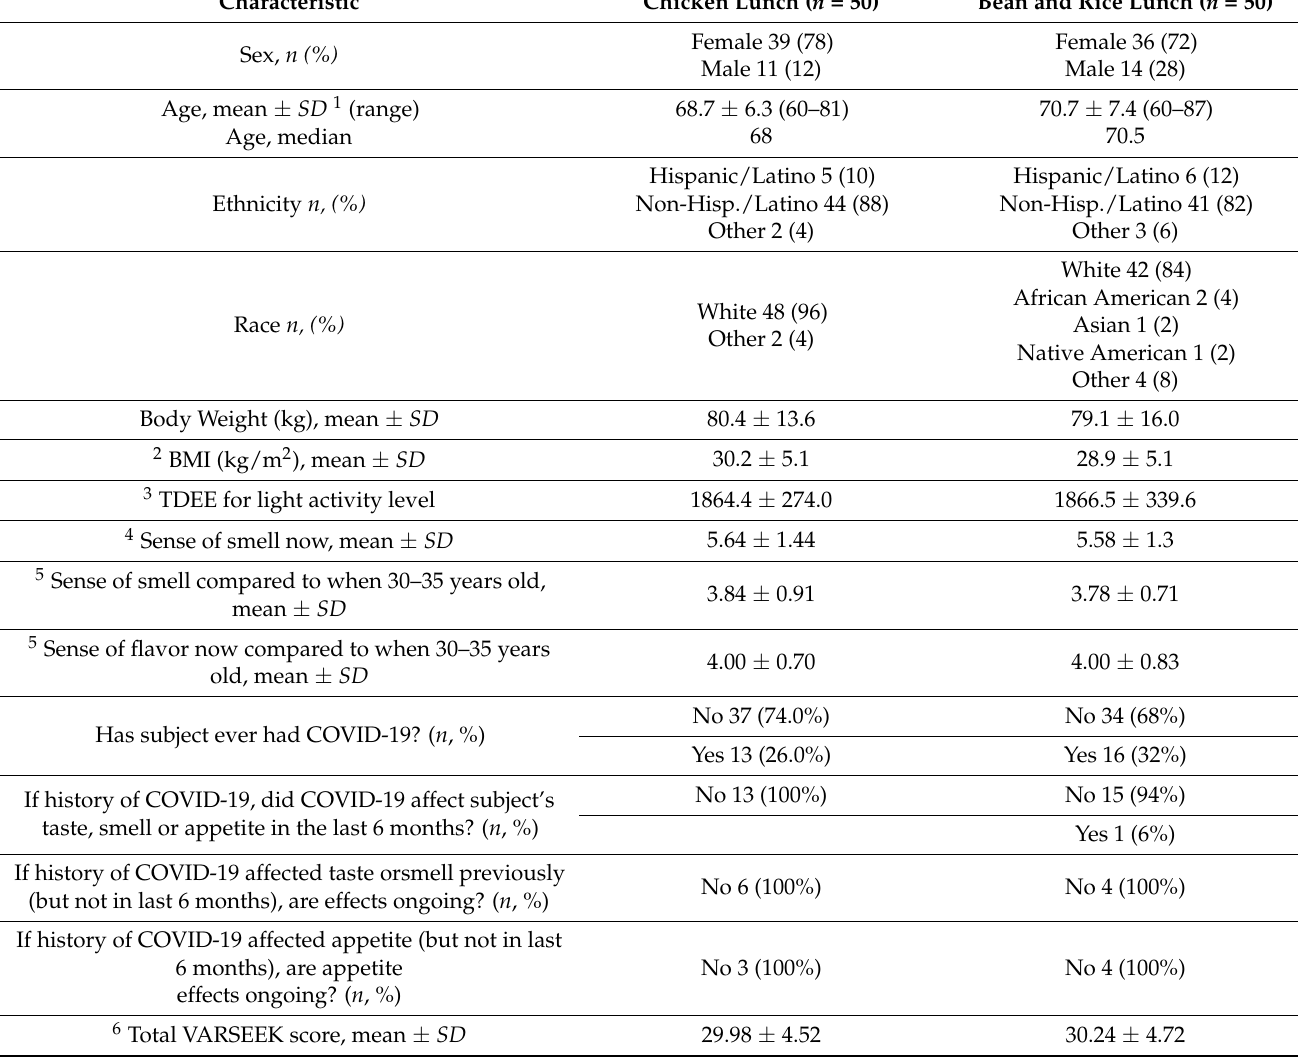
Table 1. Participant